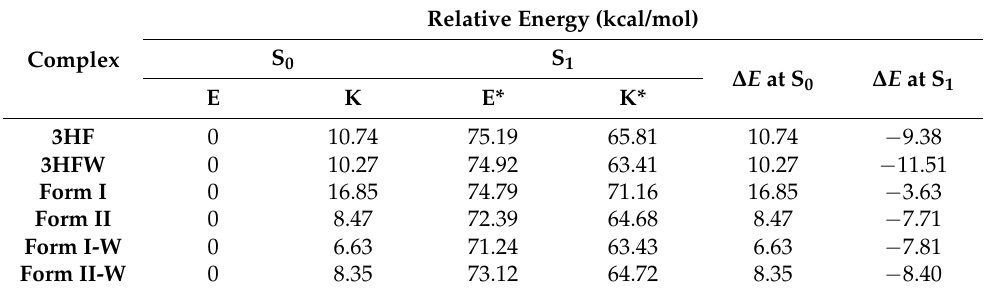
Table 4. The relative energy and computed energy differences between the E and K forms ( ∆ E = E enol − E keto ) in the S 0 and S 1 states for all